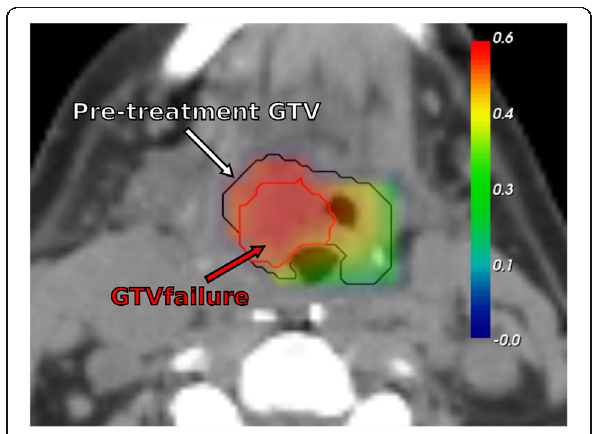
Fig. 7 Example of probability map of recurrence, generated with random forest, overlaid on the pre-treatment CT. Black contour: pre- treatment GTV. Red contour: